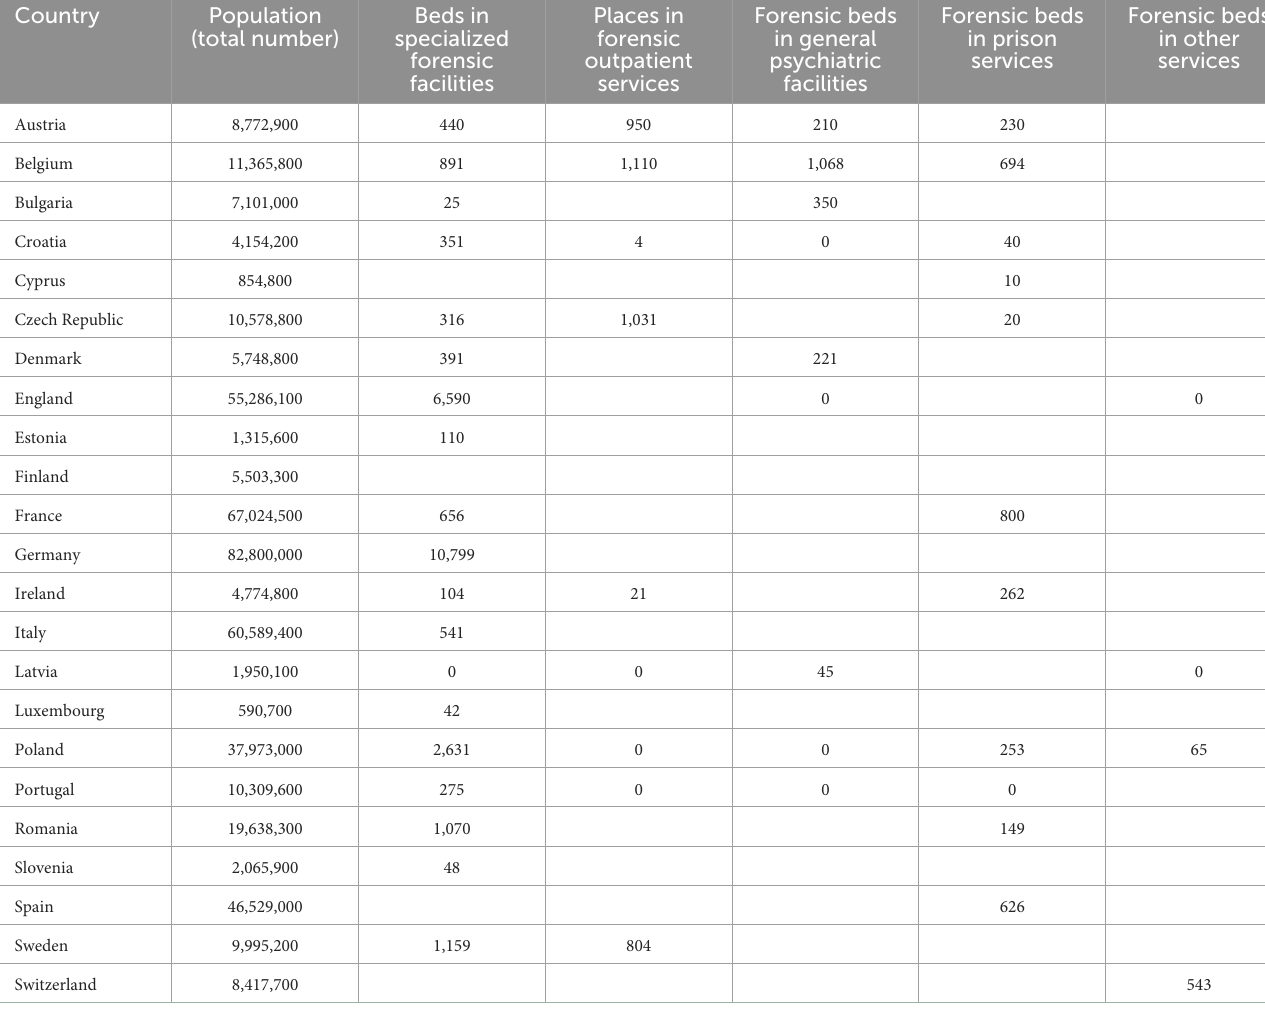
TABLE 2 Number of defined forensic psychiatric beds in European Union Member States in 2017 (empty cells: no answer or unknown). Country Population Beds in Places in (total number) specialized forensic facilities